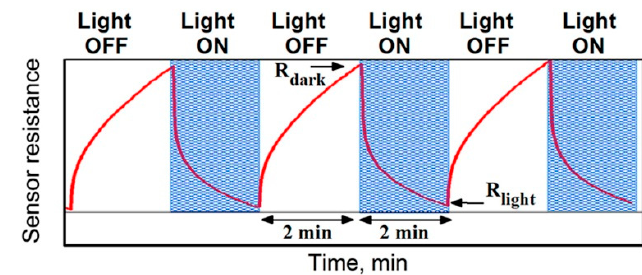
Figure 7. Scheme of resistance change of n-type semiconductor under periodic illumination.